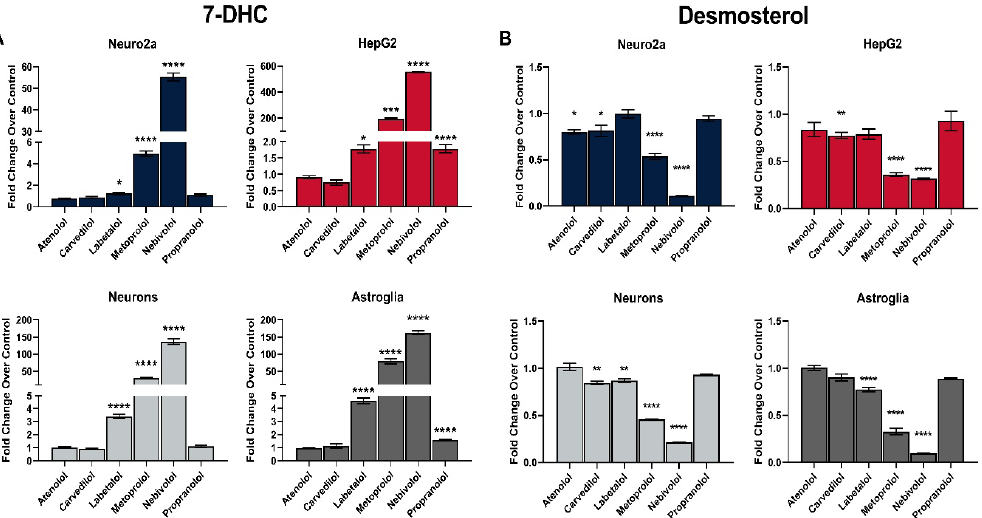
Figure 1. Select β -blockers elevate 7-DHC ( A ) and reduce DES ( B ) levels in vitro. Neuro2a, HepG2, primary neurons and astroglia were treated with 1 µM of six β -blockers or vehicle in cholesterol-free defined media for 48 h (Neuro2a and HepG2) or 6 days (neurons and astroglia). 7-DHC levels were analyzed by LC-MS/MS. The y-axes have different scales for visualization purposes. Note that NEB, MTP, and LAB robustly and significantly increase 7-DHC in all cell types. Values reported as mean ± SEM over vehicle-treated control; statistical significance: * p < 0.05; ** p < 0.01 *** p < 0.001; **** p < 0.0001.